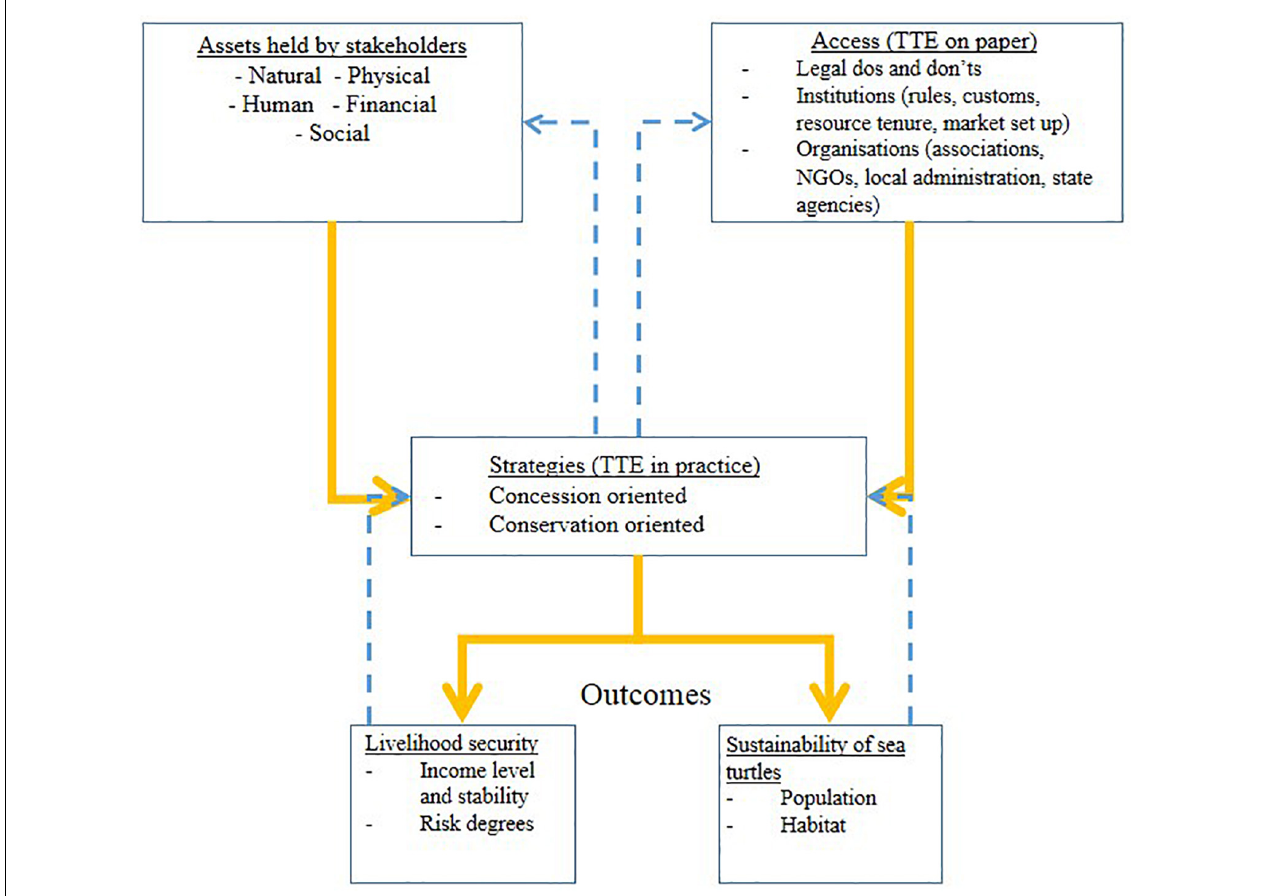
FIGURE 1 | Sustainable livelihoods approach-based theoretical framework for evaluating the Terengganu turtle egg trade policy. Yellow arrows refer to influence while dotted blue arrows refer to